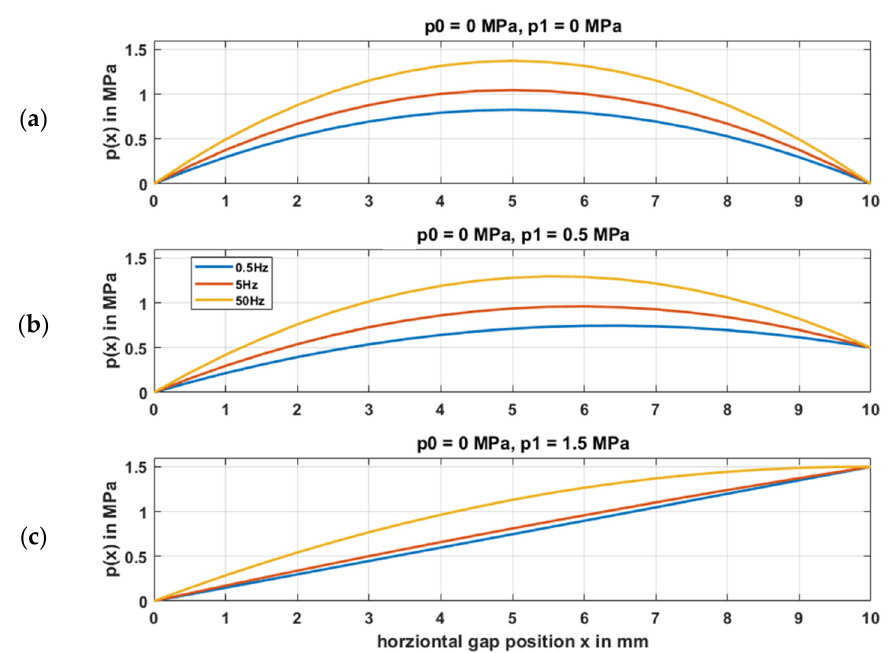
Figure 11. Inflated pressure distribution p(x) along the dynamic fluid gap at certain time min(h1(t)):